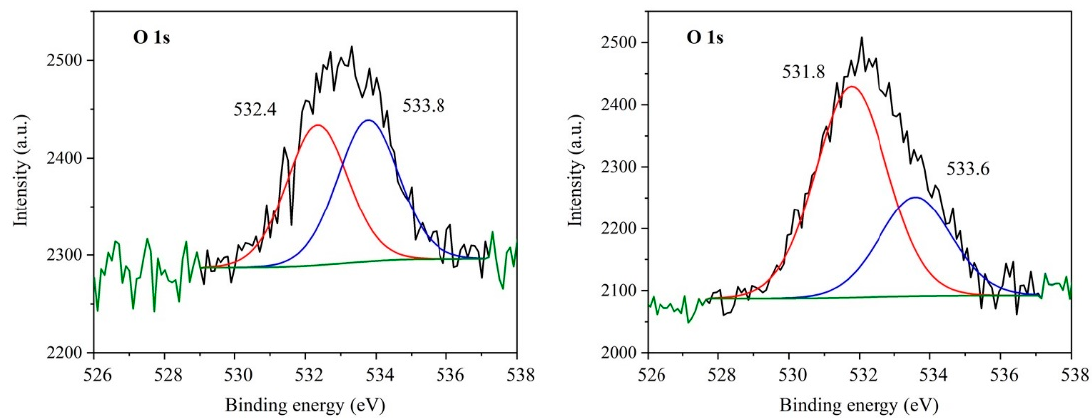
Figure 6. XPS spectra of C 1s of Ex3 ( left ) and Ex3 30 % H 2 O 2 nanomaterials ( right ).